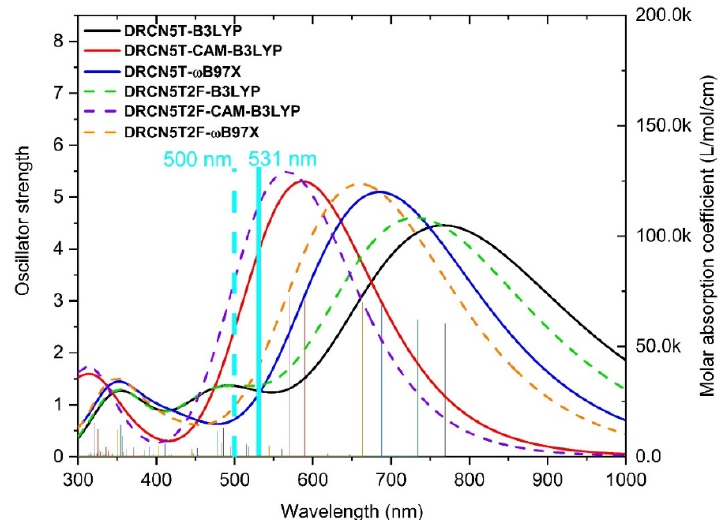
Figure 3. Simulated UV–Vis spectra of DRCN5T and DRCN5T2F with FWHM of 0.6667 eV based on different functionals with 6 − 31+G(d) basis set (black curve: B3LYP for DRCN5T; red: CAM-B3LYP for DRCN5T; blue: ω B97X for DRCN5T; green: B3LYP for DRCN5T2F; purple: CAM-B3LYP for DRCN5T2F; yellow: ω B97X for DRCN5T2F; line in light blue: experimental λ max of DRCN5T; dashed line in light blue: experimental λ max of DRCN5T2F) in